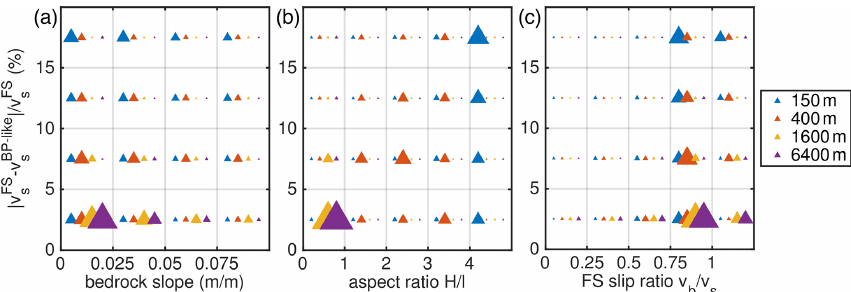
Figure 14. Two-dimensional histograms for E = 1, m = 3, P1P1GLS weak and four different grid resolutions for the outlet region. Counts of grid nodes per relative velocity error bin and per (a) bed slope bin, (b) local aspect ratio bin and (c) FS slip ratio bin. The sizes of the triangles are normalized by the total number of horizontal grid nodes of each mesh.